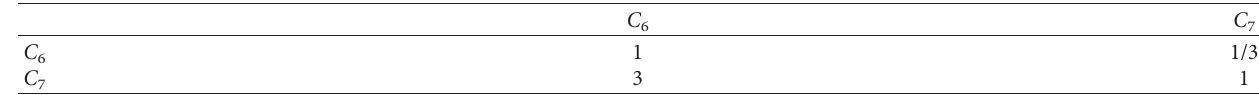
Table 6: Secondary index judgment matrix in U